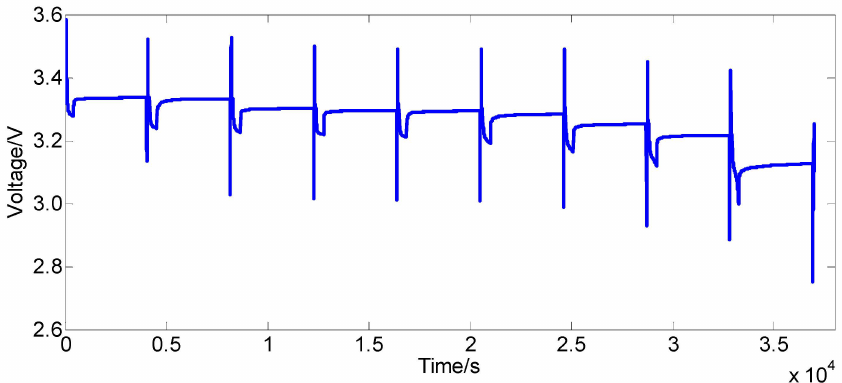
Figure 3. HPPC test